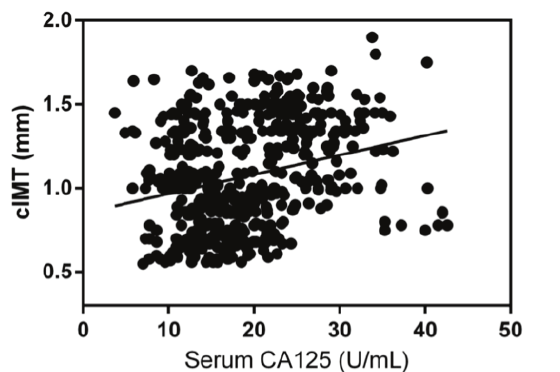
Figure 1: Serum CA 125 concentrations and cIMT in the patients with